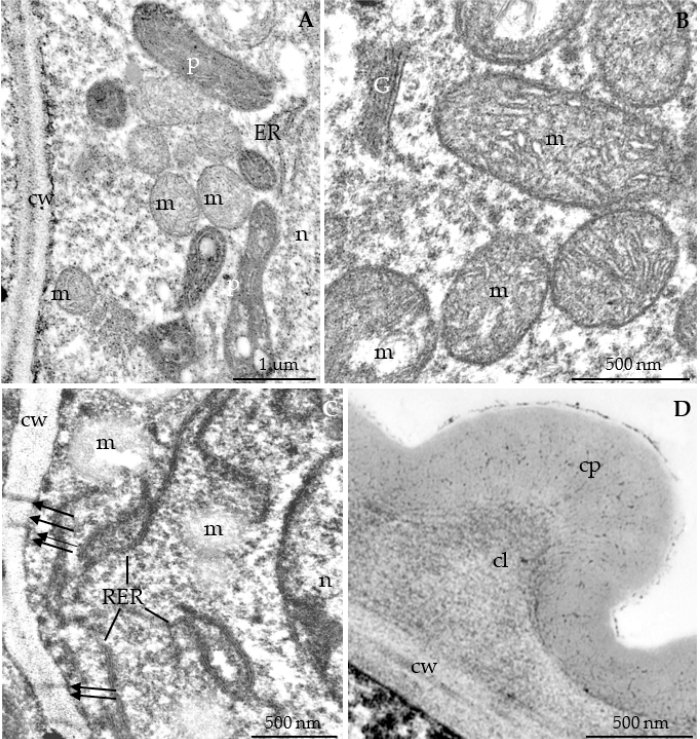
Figure 14. ( A – D ). Fragments of nectary epidermis ( A , D ) and parenchyma ( C , D ) cells in R. idaeus ‘Laszka’ in the full secretion phase. ( A ): endoplasmic reticulum (ER), cell nucleus (n), pleomorphic plastids (p), mitochondria (m) located near the cell wall (cw). ( B ): mitochondria with visible cristae (m), Golgi apparatus (G). ( C ): plasmodesmata (two arrows) in the cell wall (cw), rough endoplasmic reticulum (RER), mitochondria (m), nucleus (n). ( D ): epidermis outer cell wall (cw) with a visible cuticle proper (cp) and cuticle layer (cl).